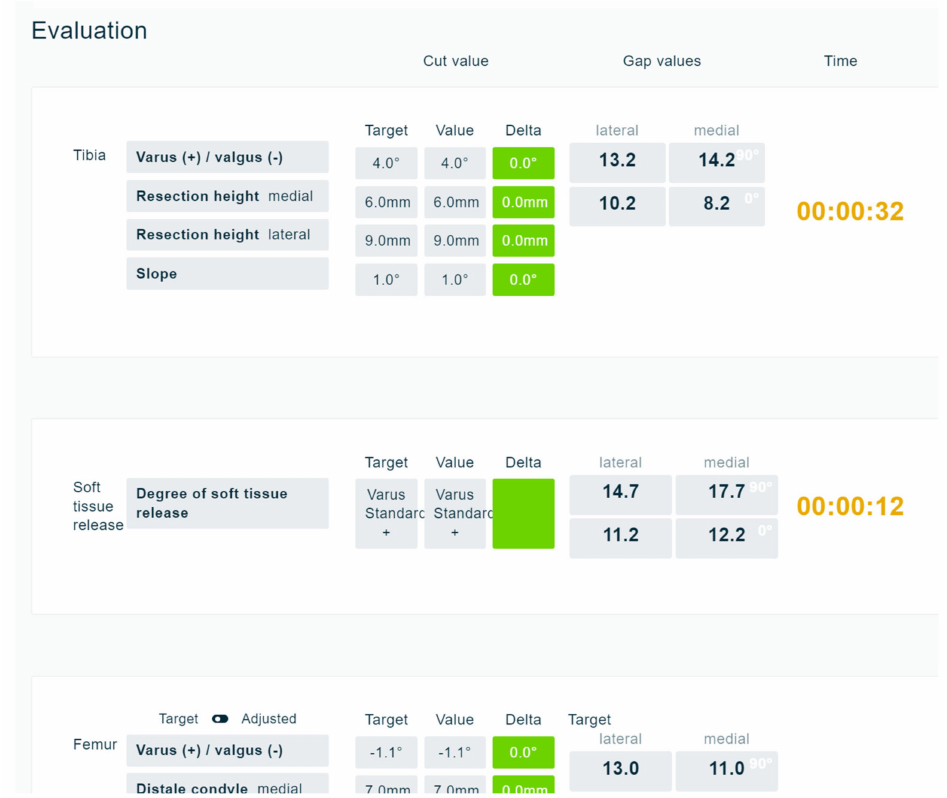
Figure 5. Part of the evaluation screen. Each decision made by the trainee is shown in the column “value” and is directly compared with the column “target”. Target values are representing the optimal, algorithm-based values. All deltas are quantified and displayed in a traffic light system. If differences are minimal (<1 mm or <1 ◦ ), in green; if maximal (>2 mm or 2 ◦ ), in red; and everything in between 1 and 2 mm or 1 and 2 ◦ , in